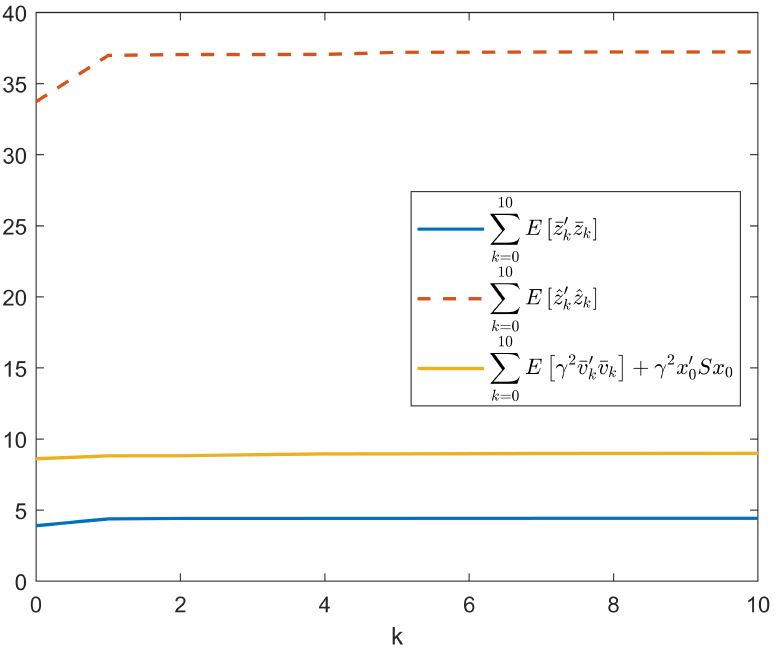
Figure 7. H ∞ performance analysis with v = 0.8 k sin ( k ) .